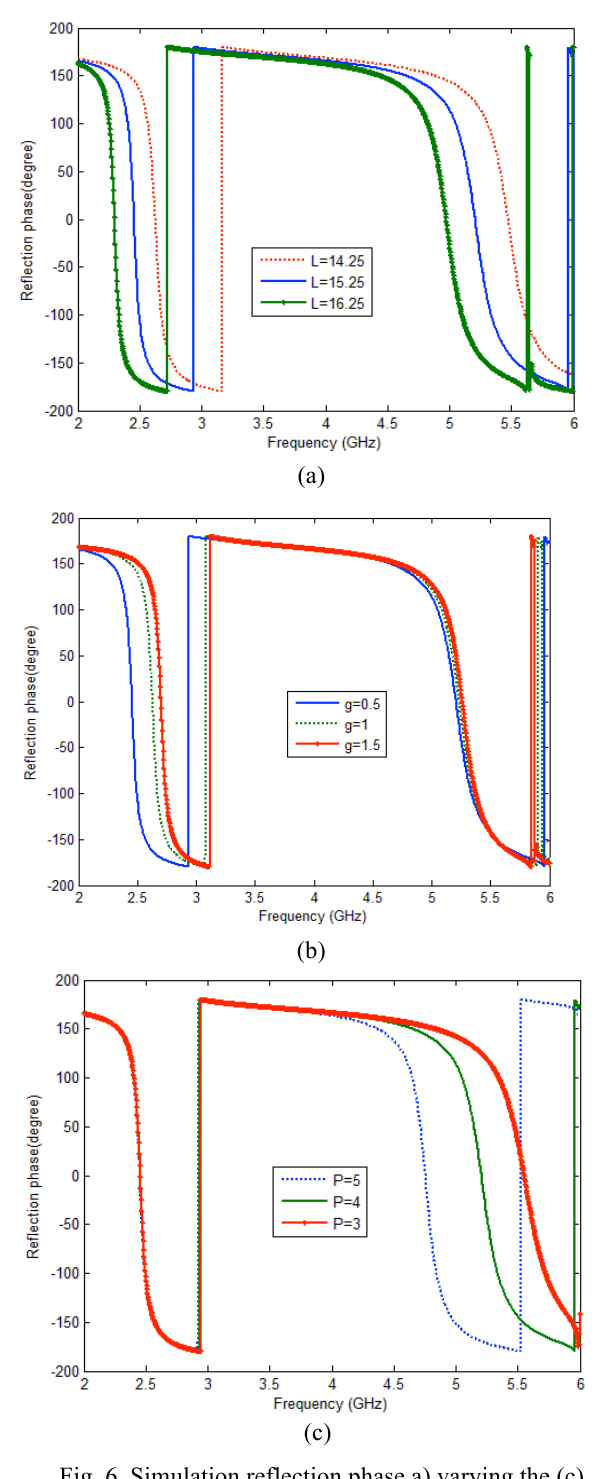
Fig .6. Simulation reflection phase a) varying the (c) length of slot L, b) varying p,c) varying the